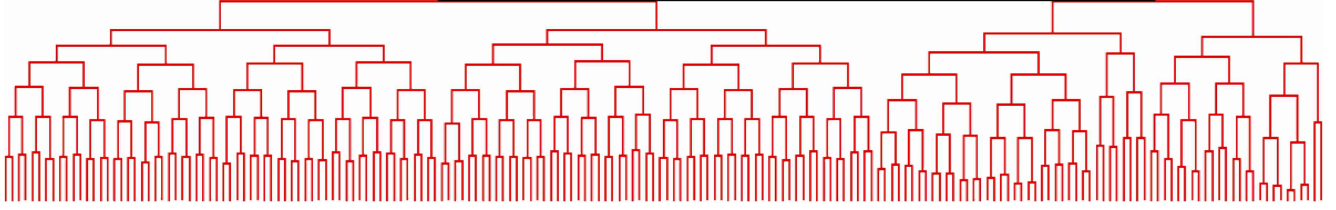
Fig 5. Cell lineage tree of simulation. Nodes represent cells with lines connectingmother and daughter cells. Lengthof the line representscell cycle